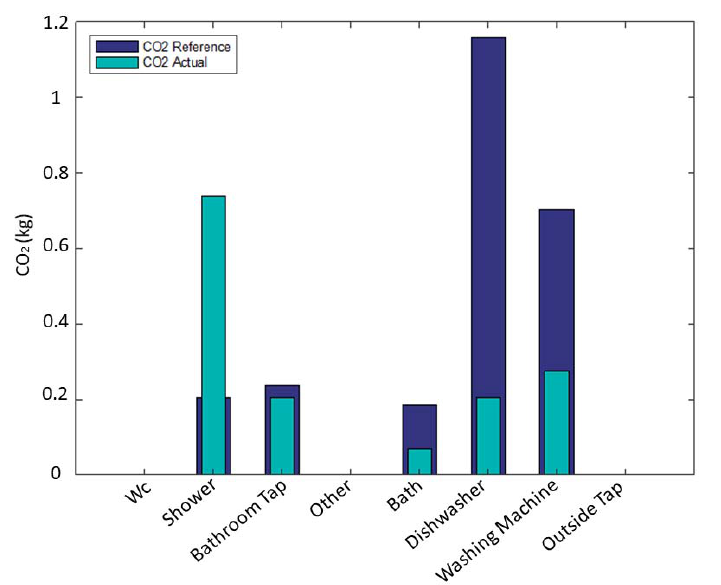
Figure 5. Environmental Indicators: comparison between the CO 2 emission (kgCO 2 ) relating end ‐ use measured volume (blue bars) and end ‐ use reference volume (red